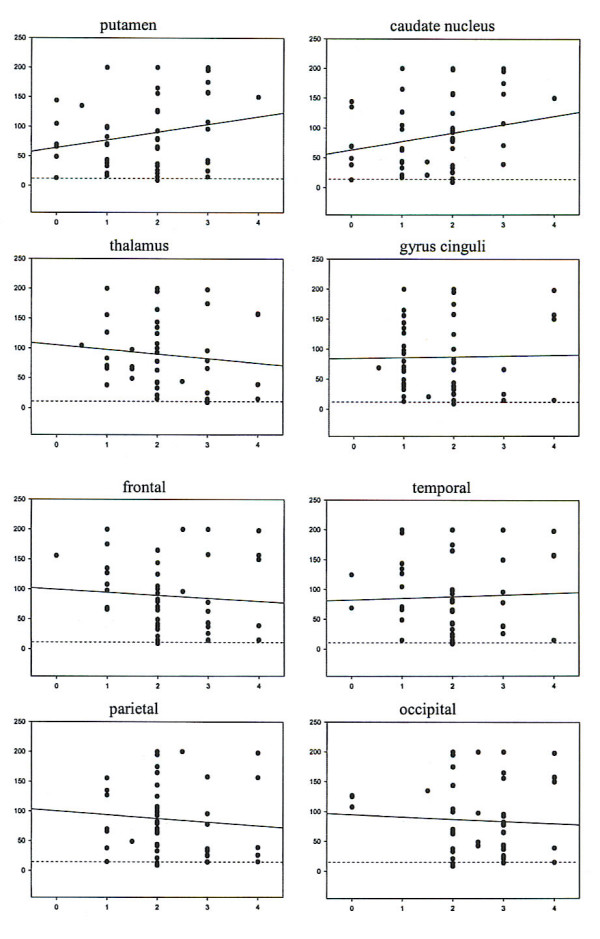
Correlation between CSF levels of neuron-specific enolase and degree of neuronal loss in various brain areas. (- - - - - - cut-off 12.5 ng/ml).